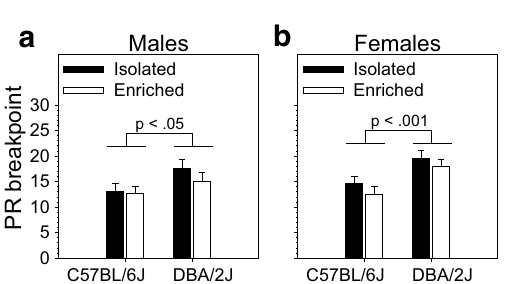
Figure 3. PR breakpoint on the OSS paradigm was significantly influenced by strain but not housing condition or sex in C57BL/6J and DBA/2J mice. (a, b) PR breakpoint for sensory stimuli-reinforced lever pressing was significantly influenced by strain (p < .001) but not sex or housing condition. DBA/2J mice reached a significantly higher breakpoint than C57BL/6J mice. This was true for both males and females.